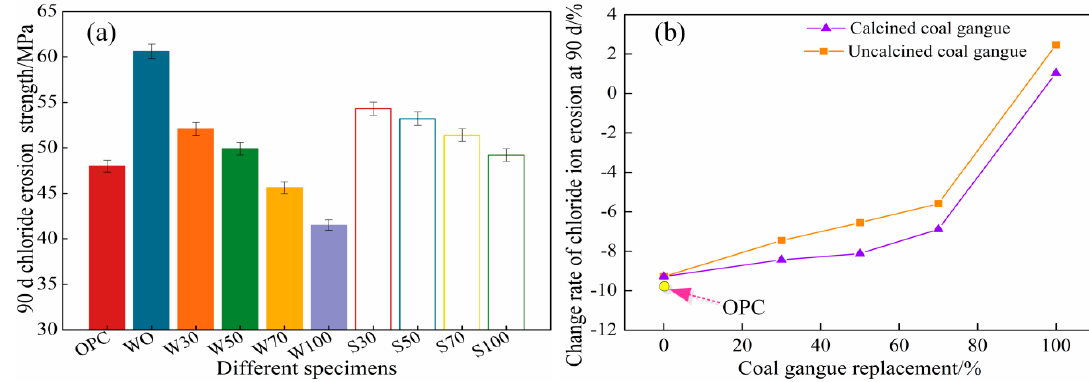
Figure 3. The 90 d chloride ion corrosion compressive strength of ( a ) and ( b ) growth rate.